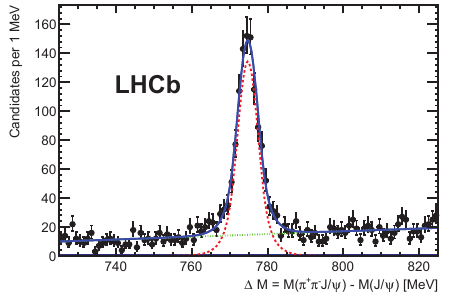
Figure 1. The fi t of the X (3872) signal to the distribution of Δ M for B + → J / Ψ K + π + π − candidates. The solid blue line represents the total fi t, dashed red line the signal component, and dotted green line indicates the background component. Figure adopted from